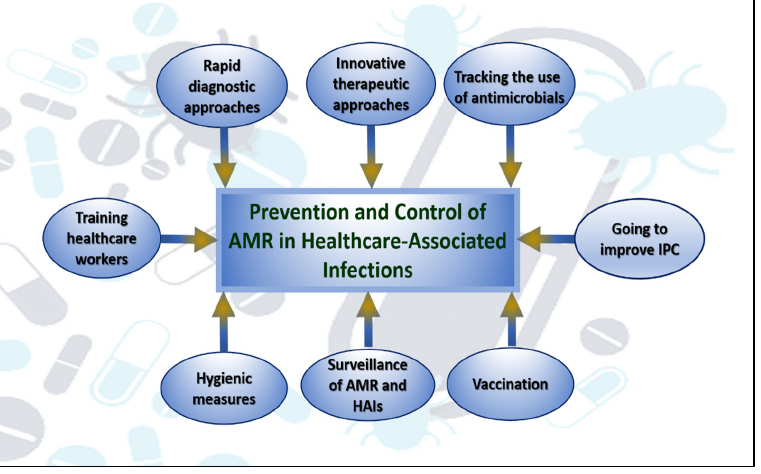
Figure 2. The fundamentals of AMR help improve the management of HAIs and reduce the negative impacts of antibiotic use. impacts of antibiotic